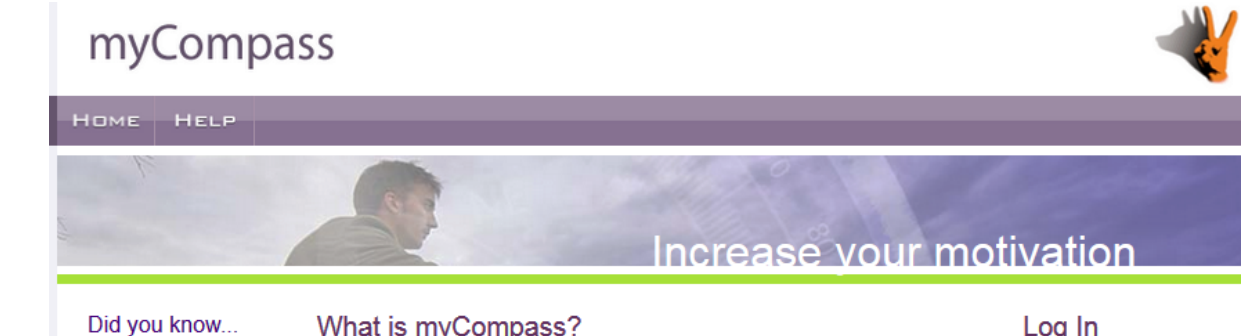
Figure 2. Screenshot of